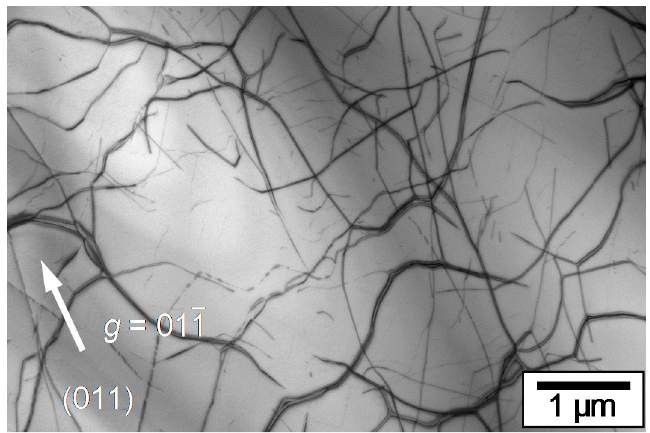
Figure 5. A typical TEM bright field image taken from the Sr / Ti = 1.04 specimen deformed at ε = 1.0 × 10 − 5 (s − 1 ) up to ε p = 3%.